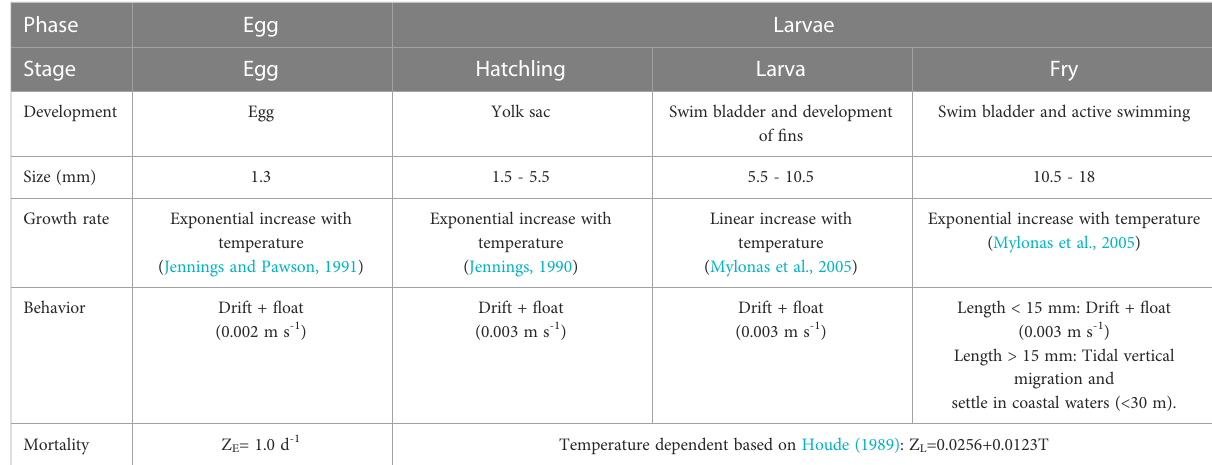
TABLE 1 Parameters used to model growth and behavior of sea bass at different pelagic developmental stages, and corresponding sizes (modi fi ed from Beraud et al., 2018).